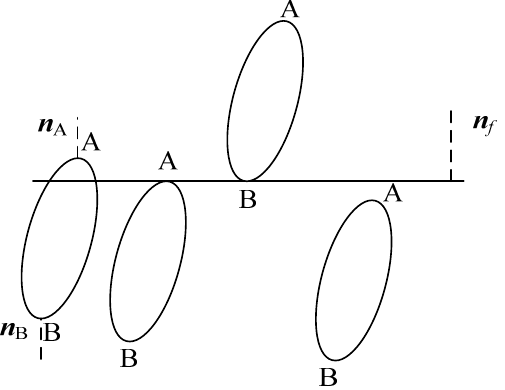
Figure 4. Sketch of the intersection of an ellipsoid with a plane. Table 2. Conditions for the intersection relationship of an ellipsoid with a plane.